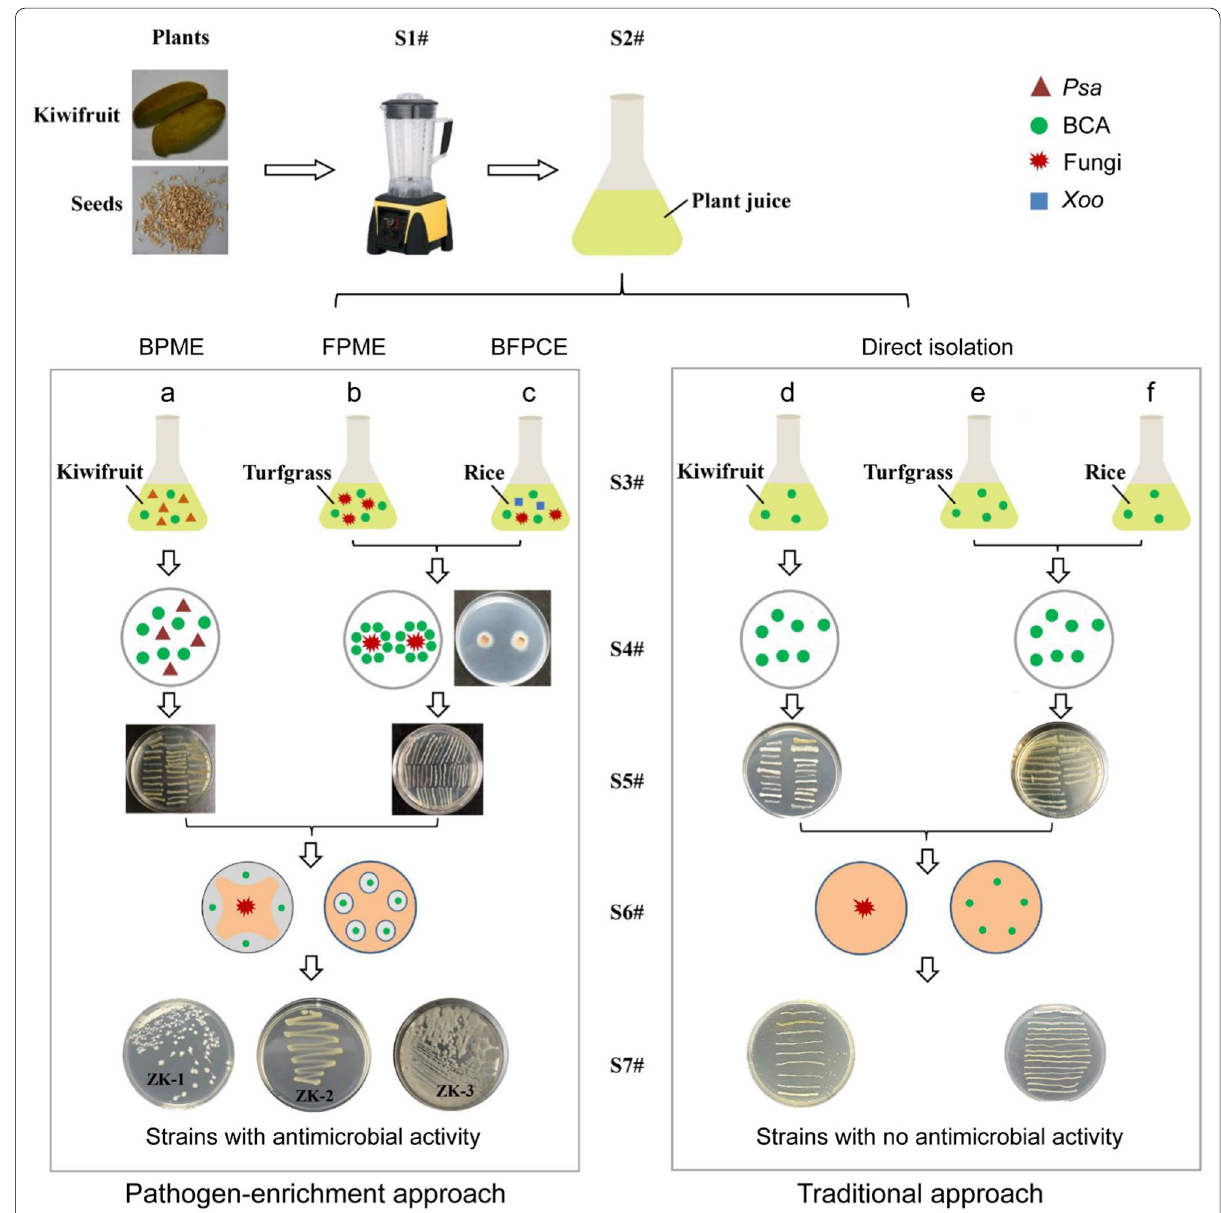
Fig. 1 Schematic diagram illustrating the targeted isolation of potential biocontrol agents from a plant-pathogen co-culture system by enriching for specific pathogens. The plant samples of interest were selected for surface sterilization with 75% ethanol, and then a high-speed blender (S1#) was used to crush the sample with sterilized water to produce a sample liquid mixture called plant juice (S2#). Left panel: Targeted isolation based on pathogen-enrichment approach. The corresponding pathogen for kiwifruit ( a ), turfgrass ( b ) or rice ( c ) in the following steps was added into the corresponding plant juice prior to co-inoculation (S3#). In this process, potential host-derived biocontrol agents (BCAs) were expected to be enriched by “eating” fed bacterial pathogens or by attaching and preying on fungal mycelia (S4#). This pathogen enrichment process can be directed to isolate a range of host-derived bacteria (S5#). These bacteria were randomly selected and tested for their antibacterial and/or antifungal activity by a typical method called the dual-culture method (S6#), resulting in the isolation of 3 potential bacterial biocontrol agents, named antibacterial ZK-1 derived from kiwifruit, antifungal ZK-2 derived from turfgrass seeds, and antibacterial and antifungal ZK-3 derived from rice seeds (S7#). Right panel: Direct isolation based on traditional approach. The plant juice of kiwifruit ( d ), turfgrass ( e ) or rice ( f ) without any pathogens (S3#). The following steps (S4#–S7#) were similar to the left